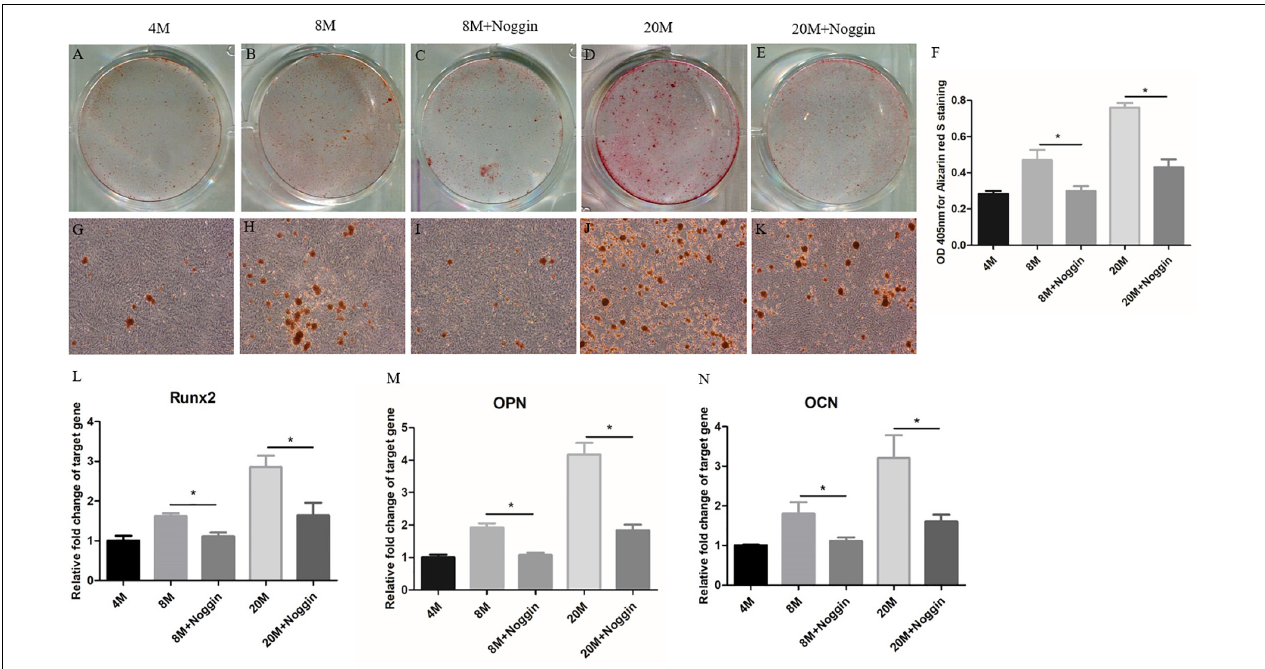
FIGURE 8 | Noggin inhibits the osteogenic differentiation of A-TSPCs. Effect of noggin on the osteogenic differentiation of A-TSPCs isolated from ossified tendon aged 8 and 20M. Graphs show that noggin inhibits osteogenic differentiation tendency of TSPCs at day 7 (A–E,G–K) as indicated by Alizarin red S staining. Statistical diagrams show the quantification of the amount of Alizarin red S bound to the calcified deposits in TSPCs with or without noggin stimulation at day 7 (F) . Statistical diagrams show the mRNA expression of Runx2 (L) , OPN (M) , and OCN (N) in TSPCs upon treatment with noggin in vitro . Magnification × 1 (A–E) and × 40 (G–K) . ∗ P <